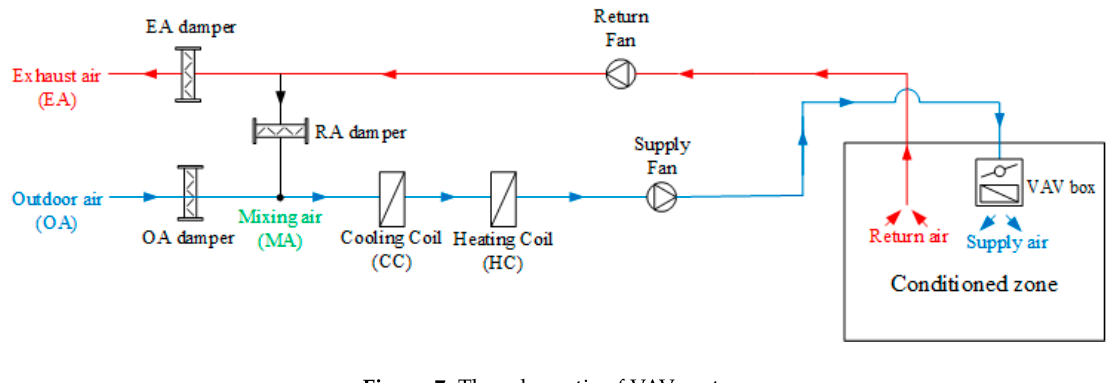
Figure 7. The schematic of VAV system.